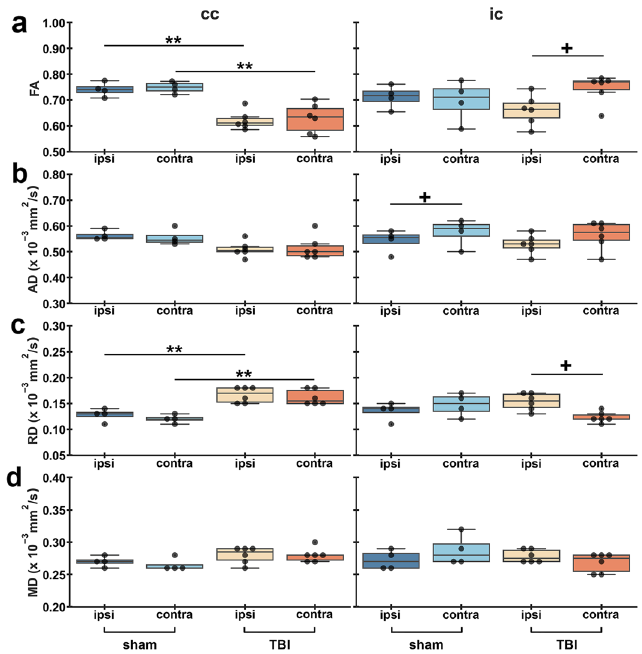
Figure 2. ROI-based analysis of tensor-based metrics in white matter areas. Results are shown as minimum, lower quartile, median, upper quartile and maximum, and paired t-test comparing ipsi- and contralateral sides within animals ( **q < 0.01) or unpaired t-test comparing the same hemisphere between sham-operated and TBI rats ( + q < 0.05) which are FDR corrected. Abbreviations: AD, axial diffusivity; cc; corpus callosum; FA, fractional anisotropy; ic; internal capsule; MD, mean diffusivity; RD, radial